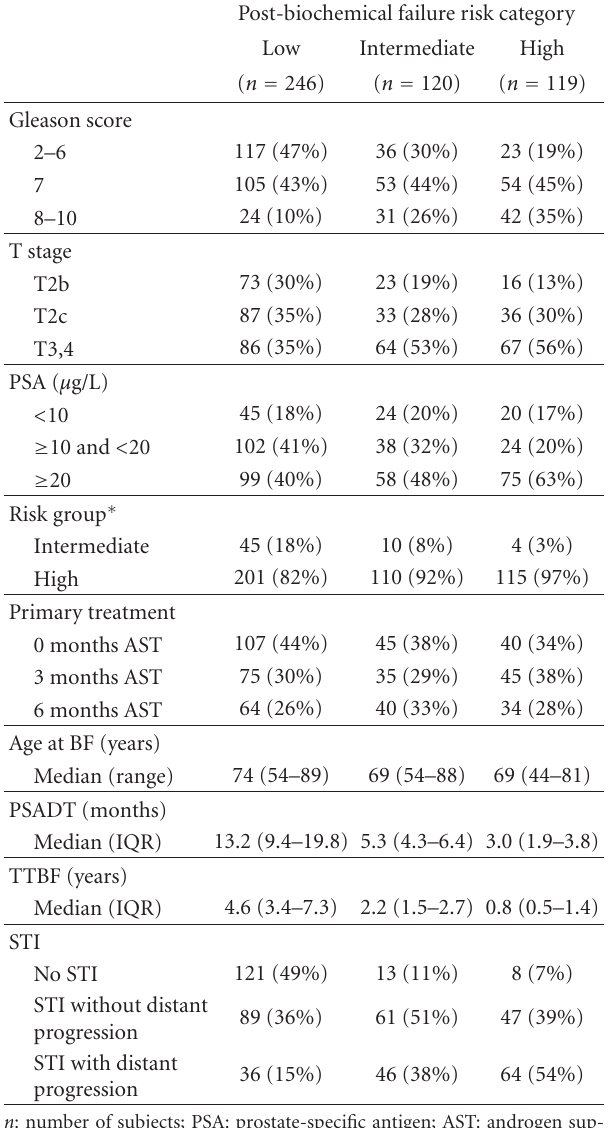
Table 3: Pre- and post-treatment characteristics of the 485 subjects who developed biochemical (Phoenix) failure before clinical failure according to the most predictive post-biochemical failure risk category (BFRC) stratification